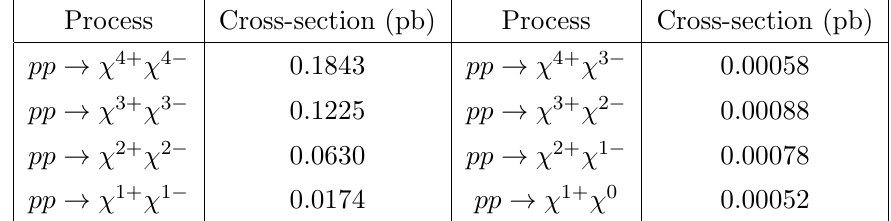
Cross-sections at the 13 TeV LHC in di(cid:11)erent production channels when M [400,409,428,456,494] GeV ( n = 0 to 4), and initial state partons and photons both are consid- ered, p = (cid:13) , q , q . The contribution from pp (cid:31) 0 (cid:31) 0 is !